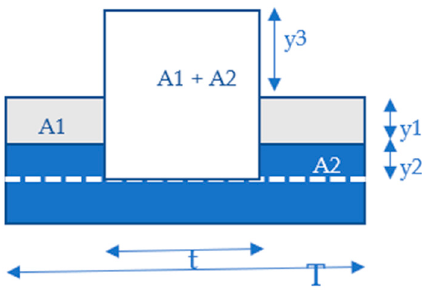
Figure 10. The effect of using a limited form of demand response-based load deactivation together with a battery.